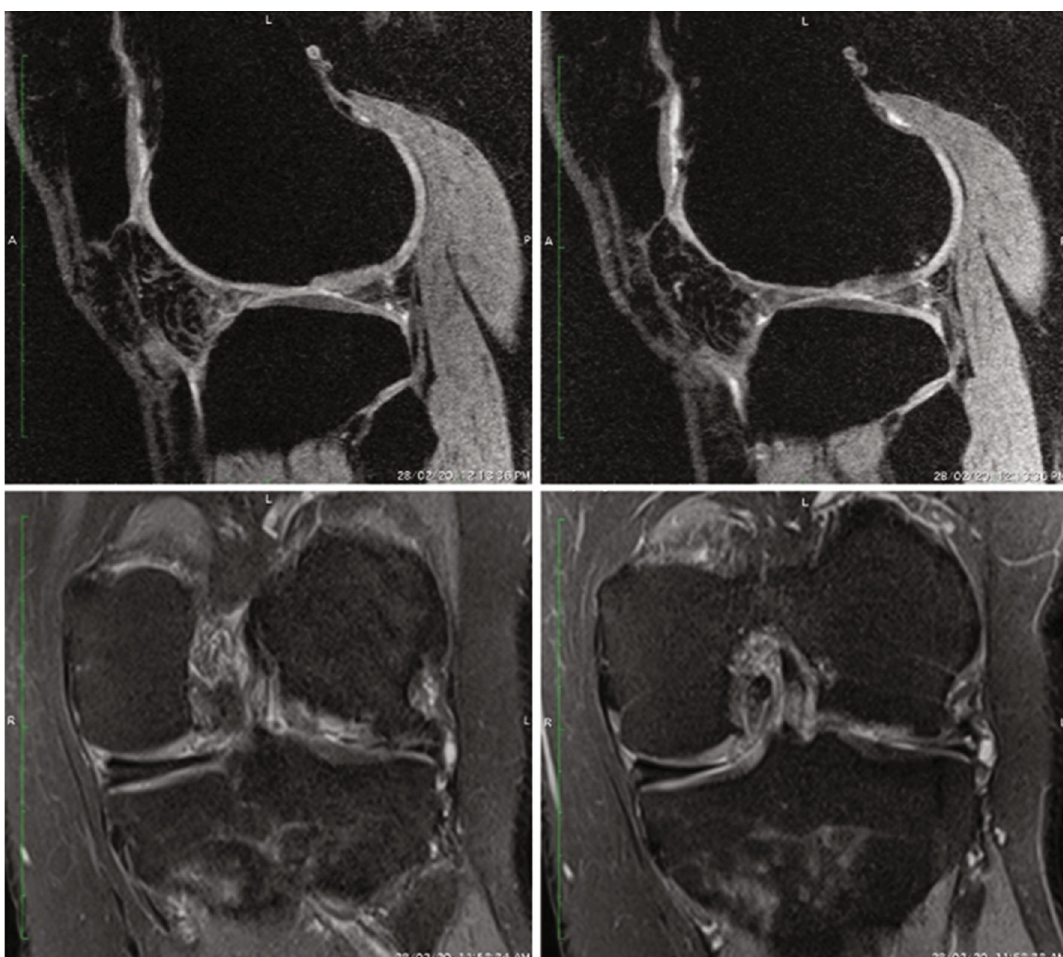
Figure 4: The MRI evaluation posttransplantation showed improvement in cartilage